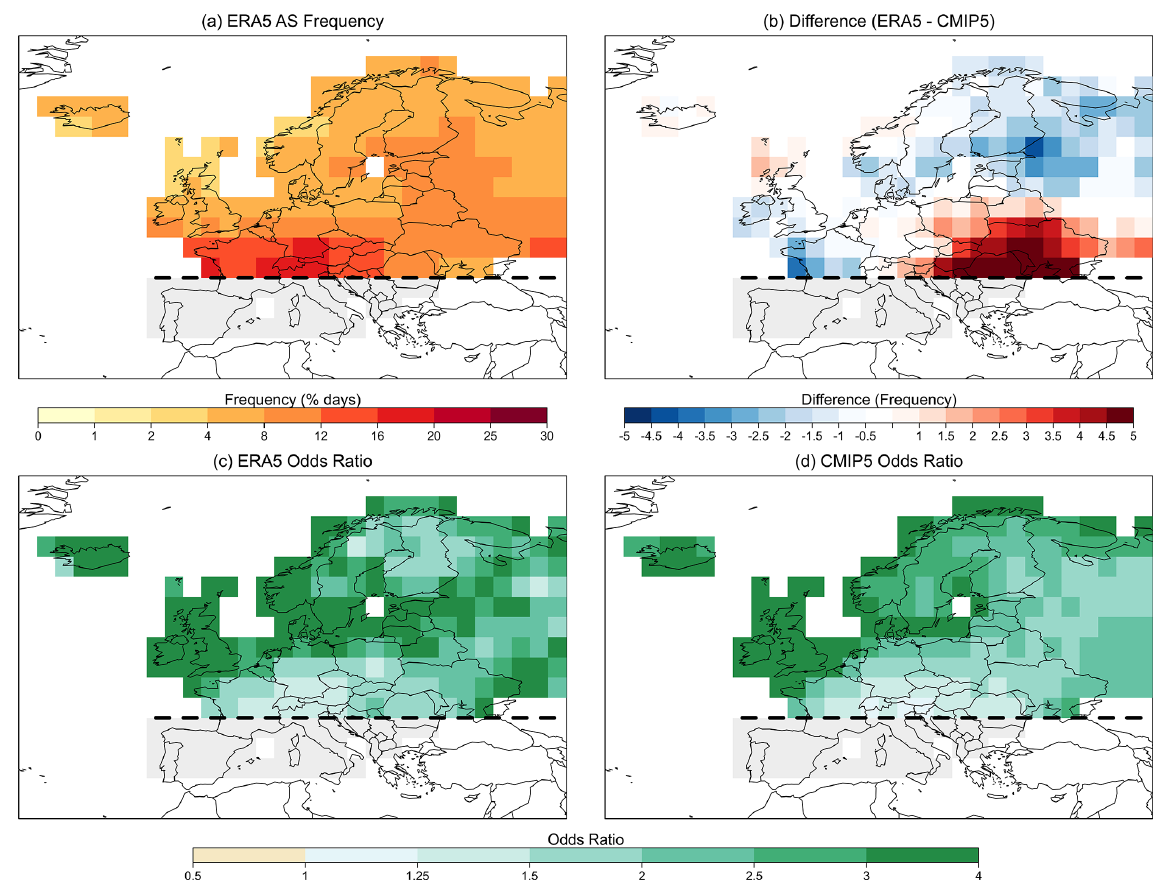
Figure 7. The frequency of anticyclonic systems (ASs) according to the algorithm from Sousa et al. (2021) in (a) ERA5 and (b) the difference between ERA5 and the CMIP5 multi-model median. Odds ratios (OR DS ) for dry spells when co-occurring with an anticyclonic system lasting at least 5d in (c) EOBS and (d) CMIP5. Grey areas indicate the masked grid cells below 40 ◦ N marked by the dashed black